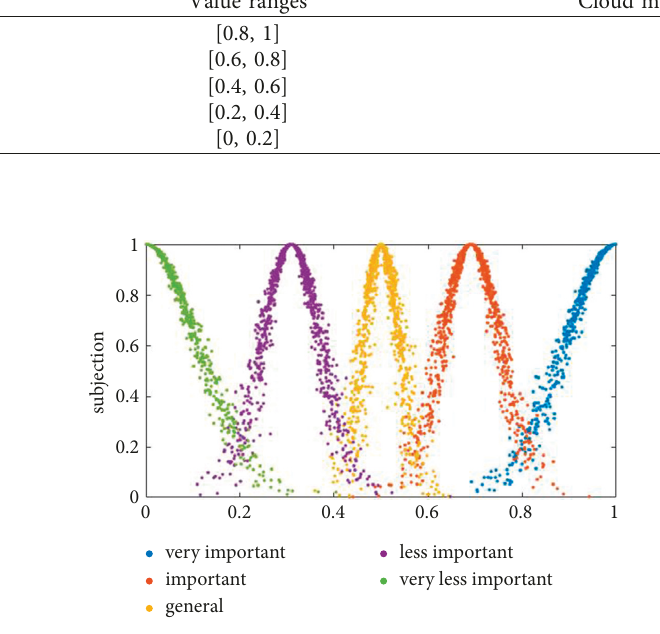
Figure 4: Cloud map of standard evaluation.